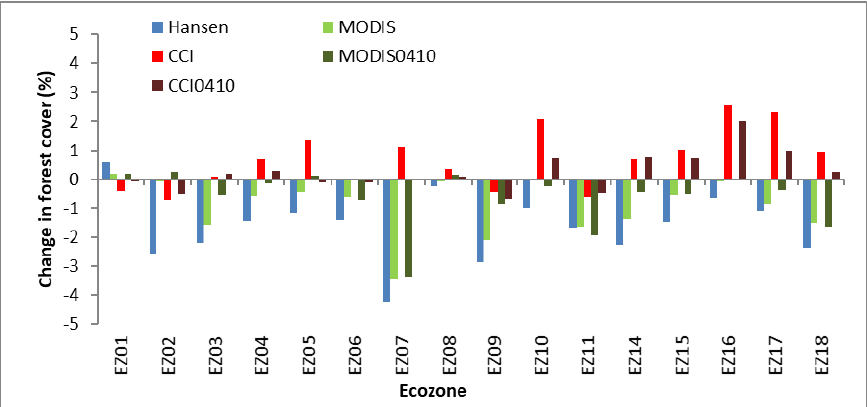
Figure 5. Change in forest cover from the Hansen, MODIS, and CCI datasets between 2000 and 2010 (solid lines). The dashed lines represent changes between 2004 and 2010. The positive values represent forest gain in 2010 and vice versa.